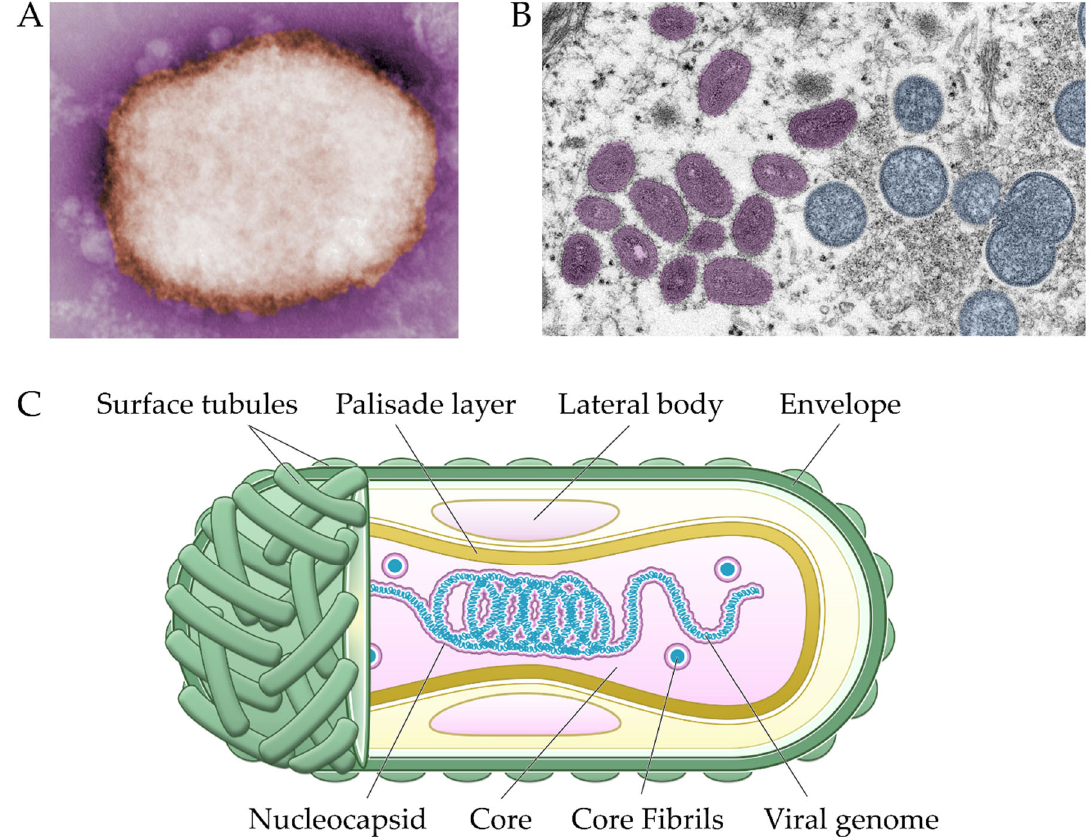
Figure 2. Negative-stained transmission electron micrograph of M-type MPXV particle ( A ). Thin section of viral particles on skin sample, showing ovoid mature virions on the left and spherical immature virions on the right. Micrographs are courtesy of the Centers for Disease Control and Prevention (CDC) Public Health Image Library (PHIL) [28] ( B ). Schematic representation of MPXV virion structure ( C